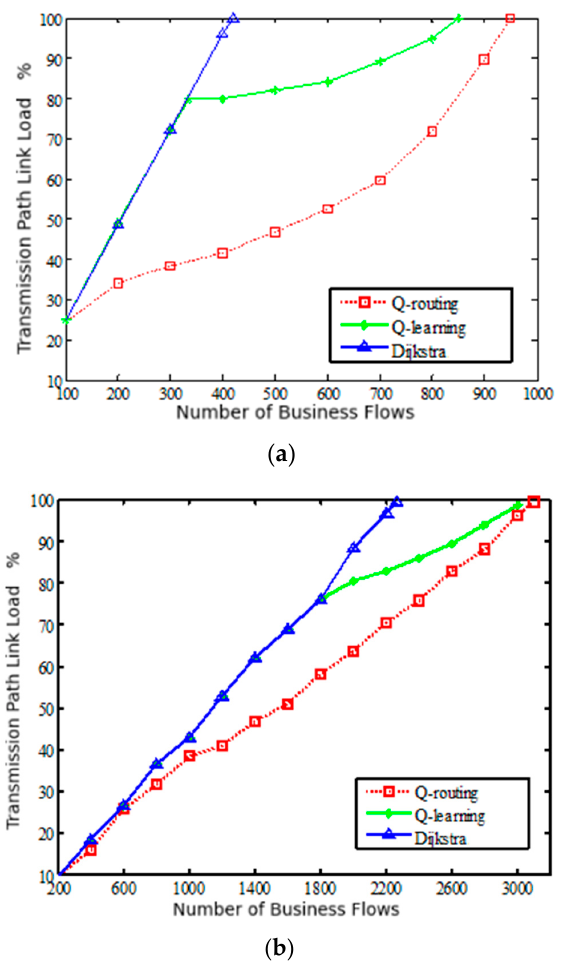
Figure 14. Comparison of service transmission path loads under different routing algorithms. ( a ) The source node and target node are fixed. ( b ) The source node and target node are random.